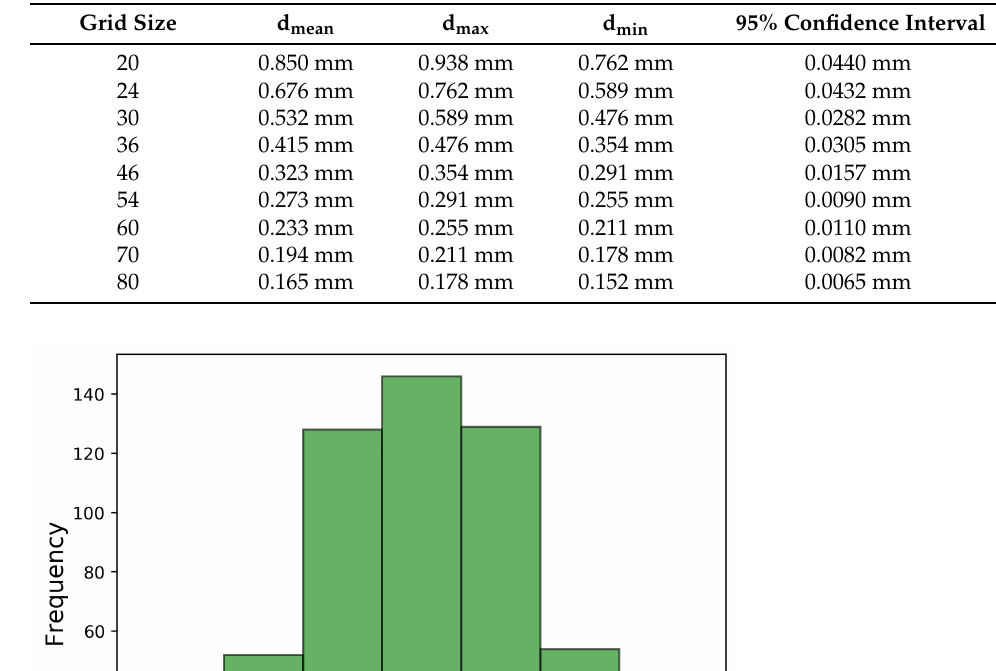
Table 2. Grain sizes and distribution used for simulation.